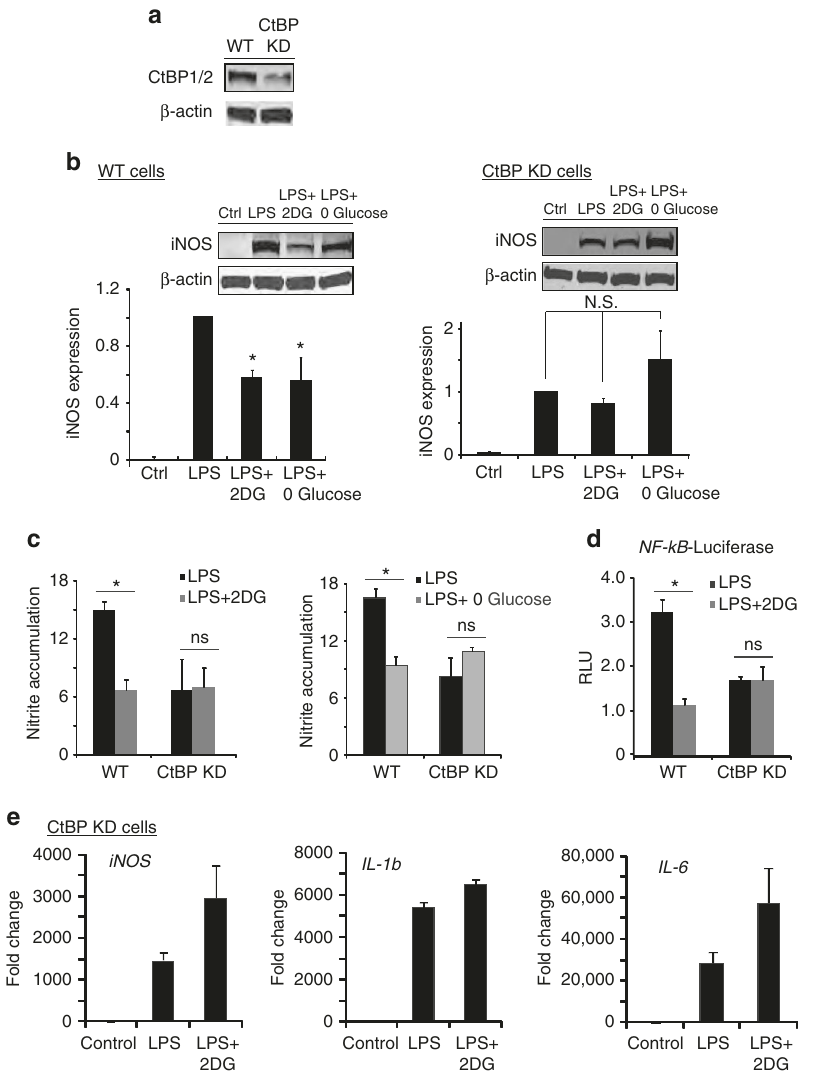
Fig. 5 Knockdown of CtBP eliminates the effects of 2DG and glucose-free medium. a Representative western blot showing reduced expression of CtBP1/2 protein in RAW264.7 cells transfected with shRNA targeting CtBP1 and CtBP2 (CtBP KD). Full length immunoblots are shown in Supplementary Fig. 3. b , c shRNA knockdown of CtBP1/2 negates the effect of both 2DG and glucose-free medium on LPS-induced iNOS expression and nitric oxide production. Results for wild-type (WT) cells were normalized to control (no LPS) WT cells, and results for CtBP knockdown cells (CtBP KD) were normalized to control CtBP KD cells. n = 4; * p < 0.05; ns, not signi fi cant. Error bars show S.E.M. d Knockdown of CtBP1/2 negates the effects of 2DG on LPS-induced NF- κ B reporter gene activation. n ≥ 3; * p < 0.05; ns, not signi fi cant. Error bars show s.e.m. e 2DG did not suppress LPS-induced transcription of iNOS , Il-1b , or IL-6 in the CtBP KD cells. n = 3. (Compare to Figs. 1d,